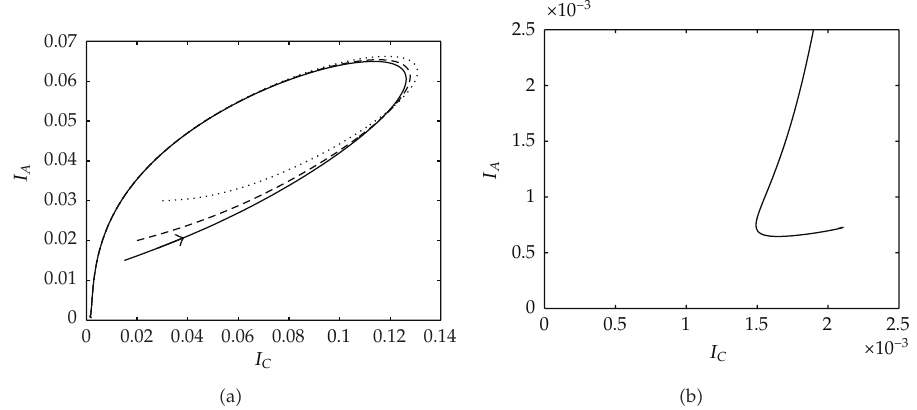
Figure 8: Projection of three orbits of model (cid:5) 2.13 (cid:6) – (cid:5) 2.18 (cid:6) on I C − I A plane (cid:5) a (cid:6) and the projection near the equilibrium state (cid:5) b (cid:6) . This projection indicates the local stability of the endemic equilibrium E f